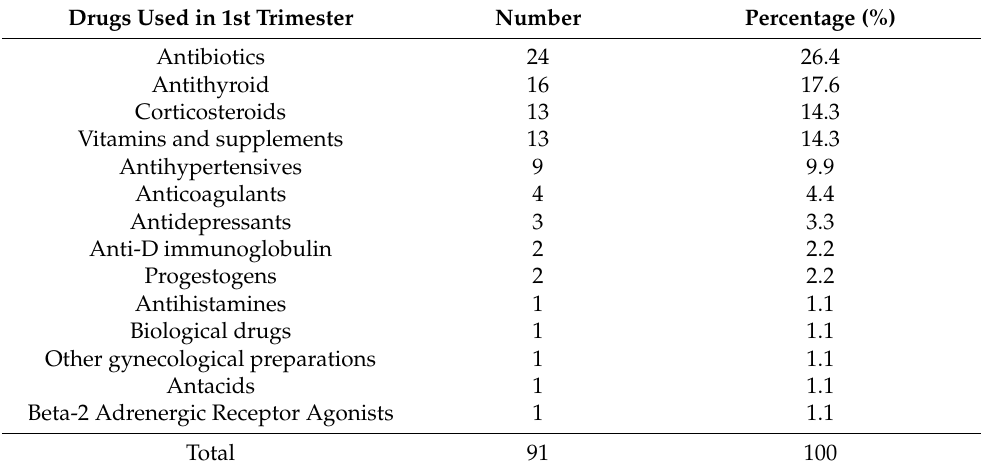
Table 7. Distribution of drugs used during the first trimester of pregnancy in the pregnant women of cases with oesophageal atresia according to the ATC classification during the period 2007–2019 in the Valencian